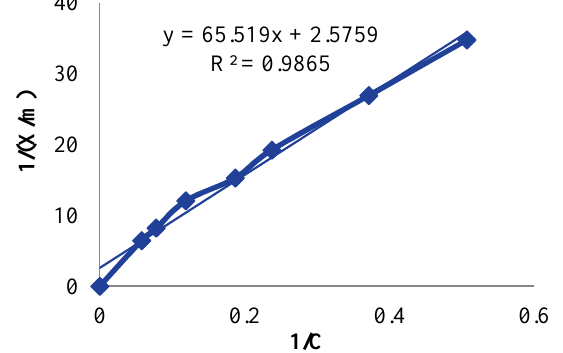
Figure 8. Langmuir model of humic acid (HA) absorption on activated acid (AC) (pH = 6-7.5, T = 25 ºC, mixing time for AC = 16 hours)